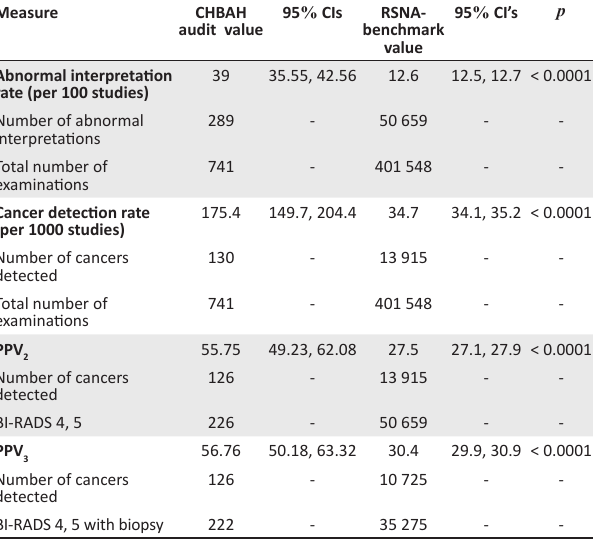
TABLE 6: Derived performance measures for diagnostic mammography ( n =